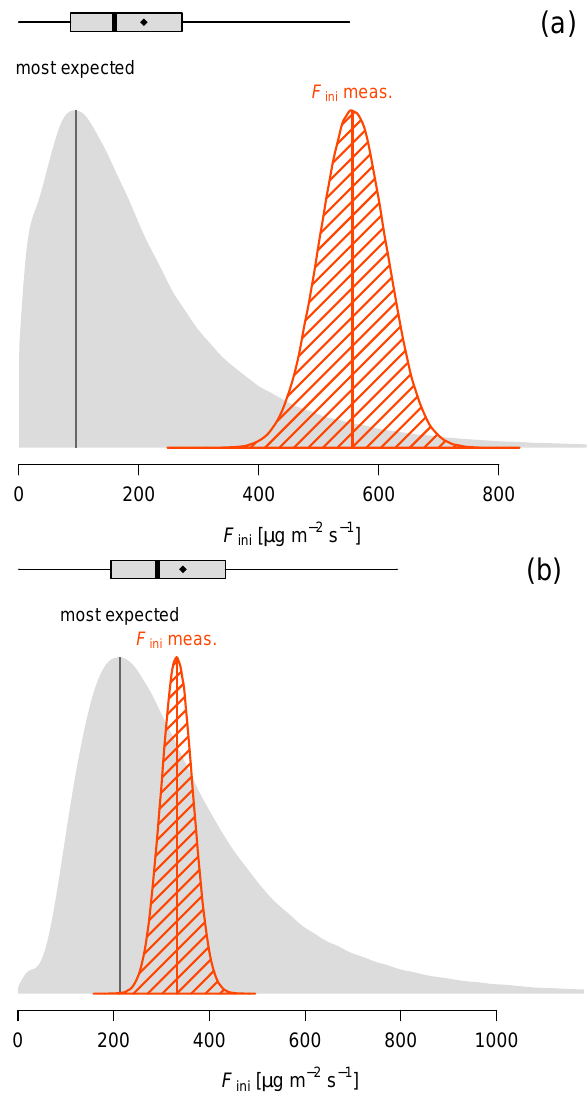
Fig. 5. Distribution of the initial flux ( F ini ) immediately after slurry spreading, derived from slurry and turbulence characteristics (grey) and from flux measurements (red) for two cases as in Table 2: (a) Menzi et al. (1998), and (b) Sintermann et al. (2011a).